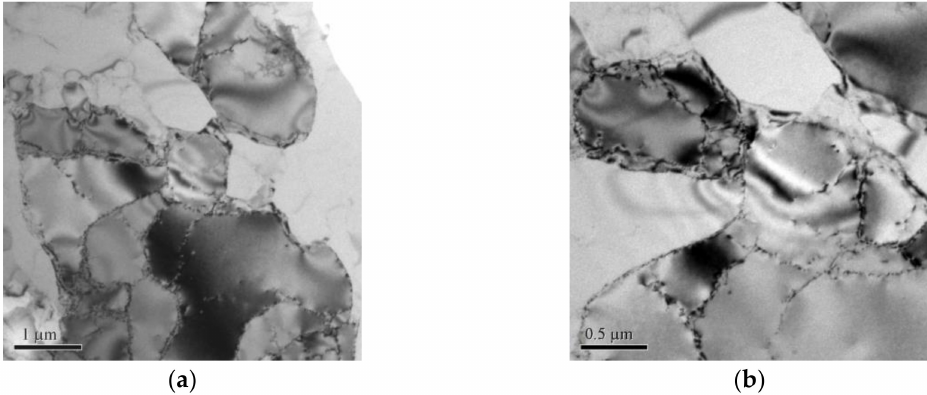
Figure 4. TEM images of alloy N2 at 50% cold rolling reduction. ( a ) with 2550 times magnification and ( b ) with 5000 times magnification.